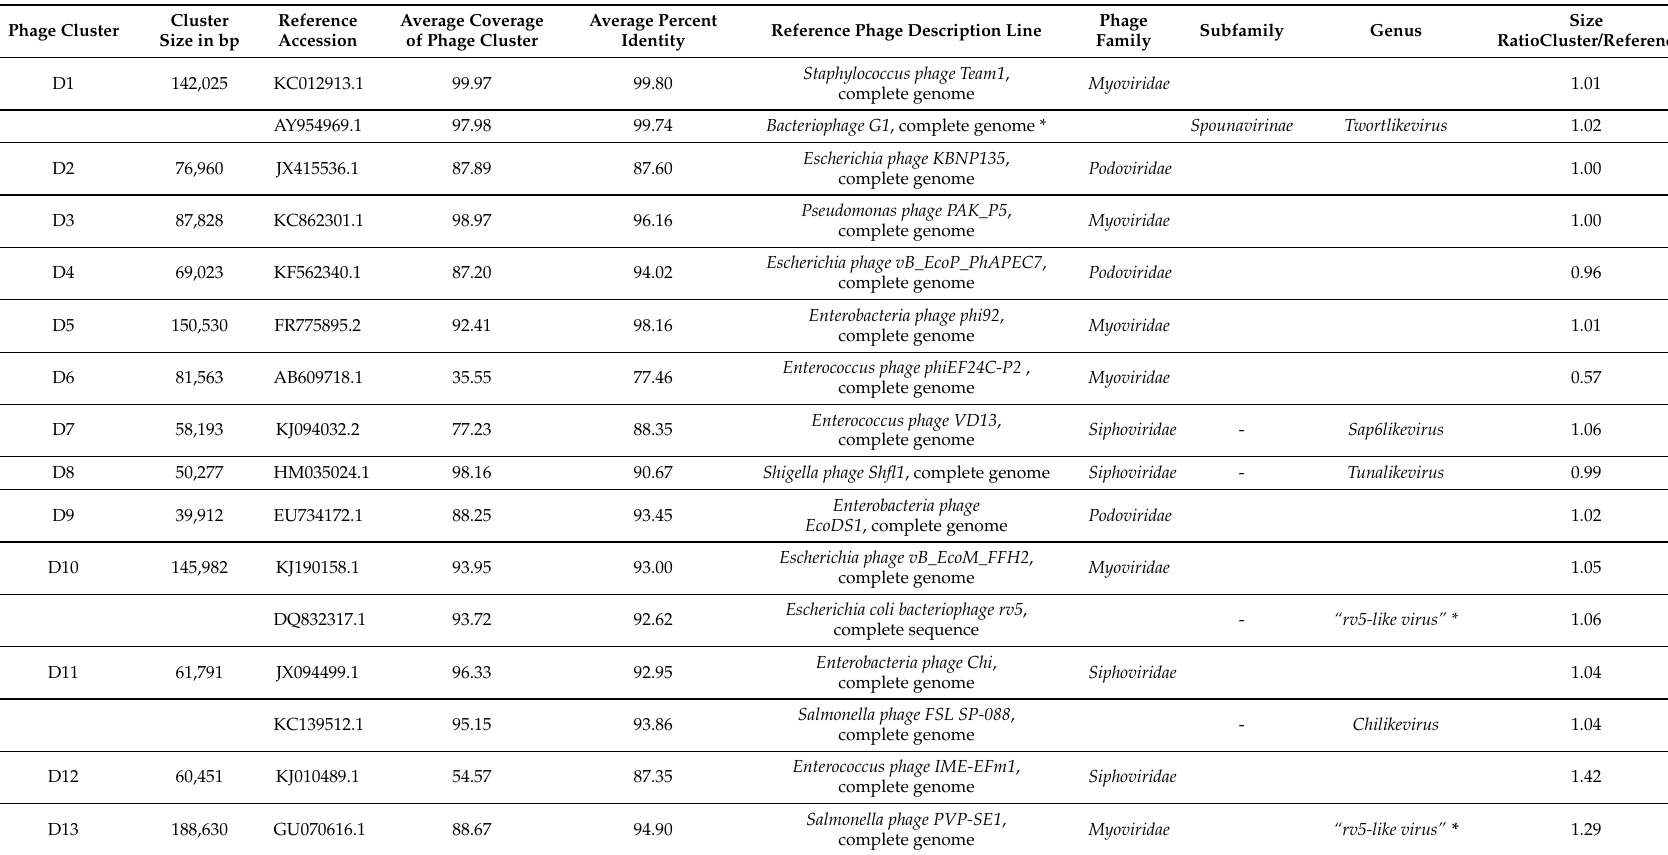
Table 2. Overview of selected characteristics of the phage clusters identified in the Intesti sample. If known, the family, subfamily and genus of the closest database reference as specified by the ICTV are given. In some cases, the closest reference phage has not been incorporated into the phage taxonomy yet but other references have. For those, both the closest reference and the closest reference within the taxonomy scheme are given. The genus “rv5-like virus” has been proposed by several authors [36,37], but is not confirmed in the current (2014) ICTV release. Remark that Bacteriophage G1 is annotated as a Staphylococcus